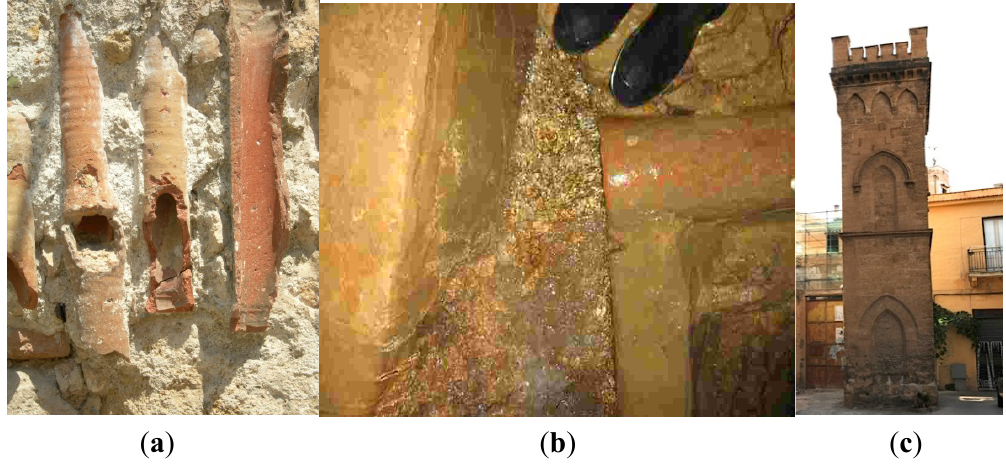
Figure 9. ( a ) catusi for drinking water supply; ( b ) saje for irrigation supply; ( c ) sharing water tower ( castelletto ) in Piazza delle Fate - Albergheria